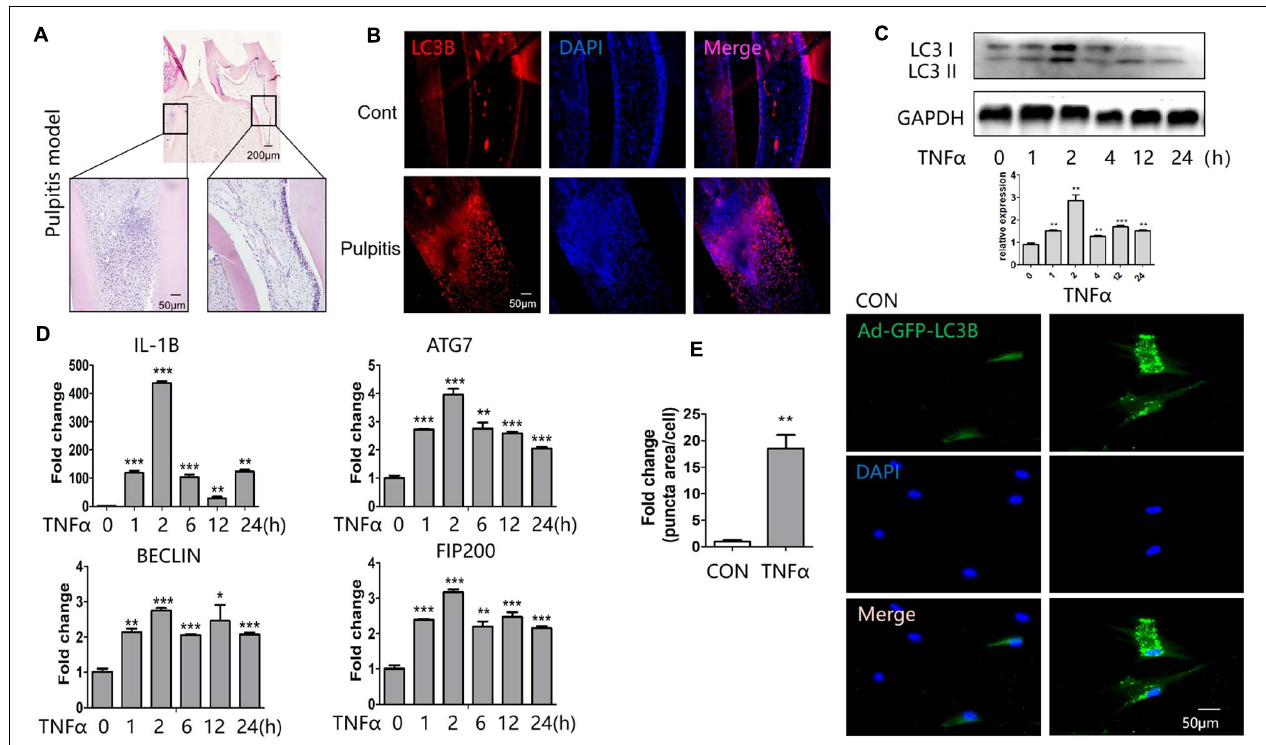
FIGURE 1 | Expression of LC3B and autophagy-related genes in response to TNF α stimulation. (A) Hematoxylin-eosin stained sections of healthy (right) and inflamed (left) dental pulp. (B) Immunofluorescent staining revealed enhanced expression of LC3B in pulpitis tissue (down) compared with control pulp (up). (C) Western blot analysis of LC3B expression at indicated time point of TNF α stimulation in HDPCs. Below was the quantification of the bands relative to the control. (D) QPCR analysis of inflammatory and autophagic genes at indicated time point of TNF α stimulation in HDPCs. (E) GFP-LC3 puncta was enhanced in response to TNF α stimulation in GFP-LC3B-expressing HDPCs. The relative quantification was on the left side. * P < 0.05, ** P < 0.01, *** P <